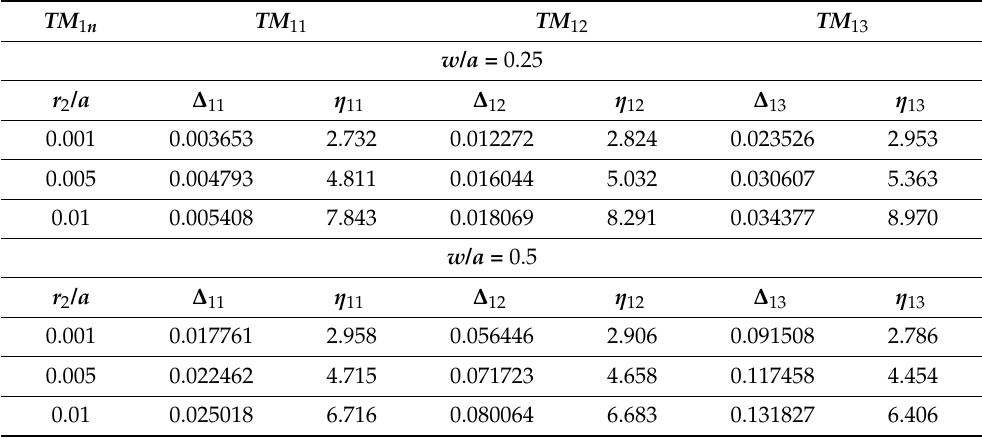
Table 5. Enhancement coefficients 𝜂 (cid:2869)(cid:3043) and real parts of the shifts Δ (cid:2869)(cid:3043) (𝑝 = 1,2,3) for complex eigenvalues of slotted (𝑤 𝑎⁄ = 0.25, 0.5) rectangular cavity in a presence of the wires ( 𝑟 (cid:2870) 𝑎 = 0.001, 0.005, 0.01⁄ ) . 𝑻𝑴 𝑻𝑴 𝟏𝒏 𝟏𝟏 𝒘 𝒂⁄ = 𝟎. 𝟐𝟓 𝒓 𝟐 𝒂⁄ Δ (cid:2869)(cid:2869) η (cid:2869)(cid:2869)